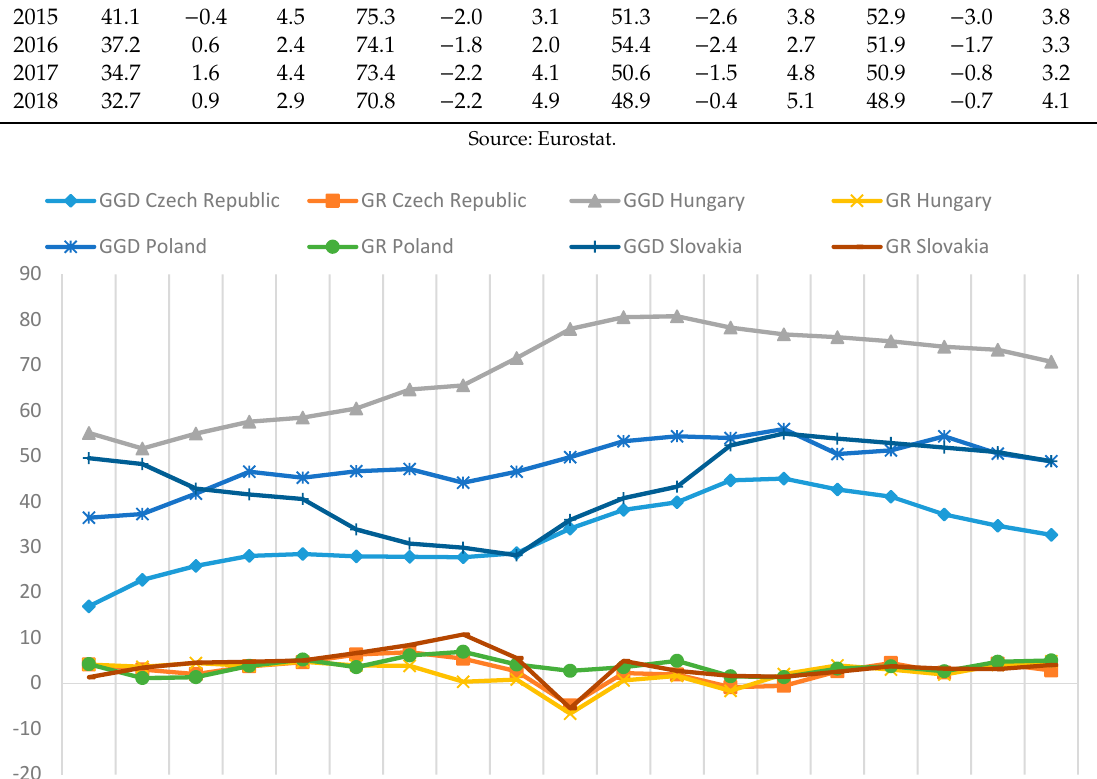
2000 2001 2002 2003 2004 2005 2006 2007 2008 2009 2010 2011 2012 2013 2014 2015 2016 2017 2018 Figure 4. Central and Eastern European countries’ GGD percentage of GDP versus growth rate percentage change from previous year, 2000–2018; Source: Eurostat.